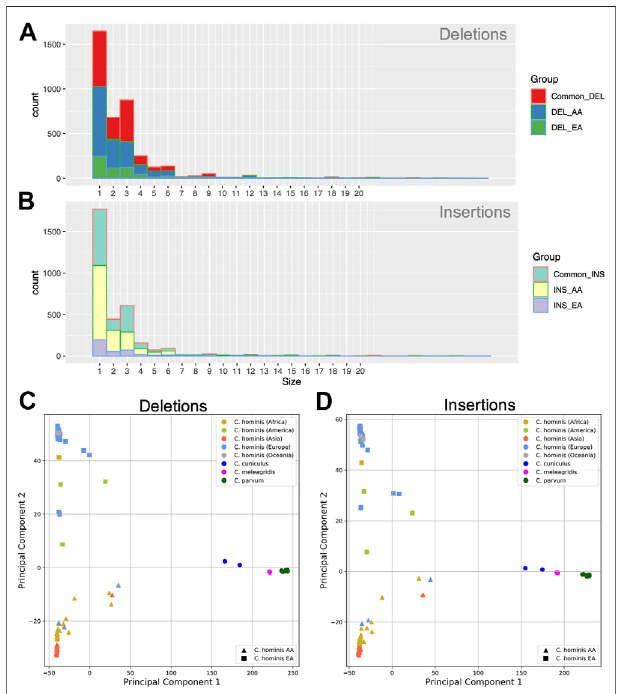
FIGURE 4 | Genomic insertion and deletion events in C. hominis lineages. (A) Genomic deletion event length (base pair) frequency common to both lineages (Common_DEL), EA and AA. DEL_AA: Speci fi c to the AA lineage. DEL_EA: speci fi c for the EA lineage. (B) Genomic Insertion eventslength(basepair)frequencycommontobothlineages(Common_INS), EA and AA. INS_AA: Speci fi c to the AA lineage. INS_EA: speci fi c for the EA lineage. (C) Principal component analysis (PCA) of the genomic deletion events detected in C. hominis . (D) Principal component analysis (PCA) of the genomic insertion events detected in C. hominis